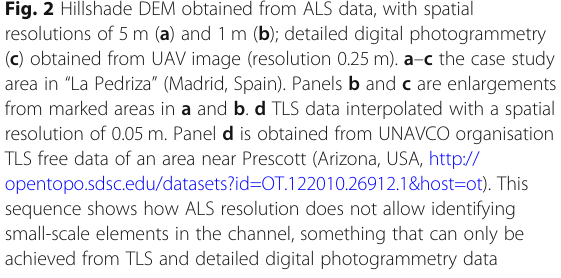
Fig. 2 Hillshade DEM obtained from ALS data, with spatial resolutions of 5 m ( a ) and 1 m ( b ); detailed digital photogrammetry ( c ) obtained from UAV image (resolution 0.25 m). a – c the case study area in “ La Pedriza ” (Madrid, Spain). Panels b and c are enlargements from marked areas in a and b . d TLS data interpolated with a spatial resolution of 0.05 m. Panel d is obtained from UNAVCO organisation TLS free data of an area near Prescott (Arizona, USA, http:// opentopo.sdsc.edu/datasets?id=OT.122010.26912.1&host=ot). This sequence shows how ALS resolution does not allow identifying small-scale elements in the channel, something that can only be achieved from TLS and detailed digital photogrammetry